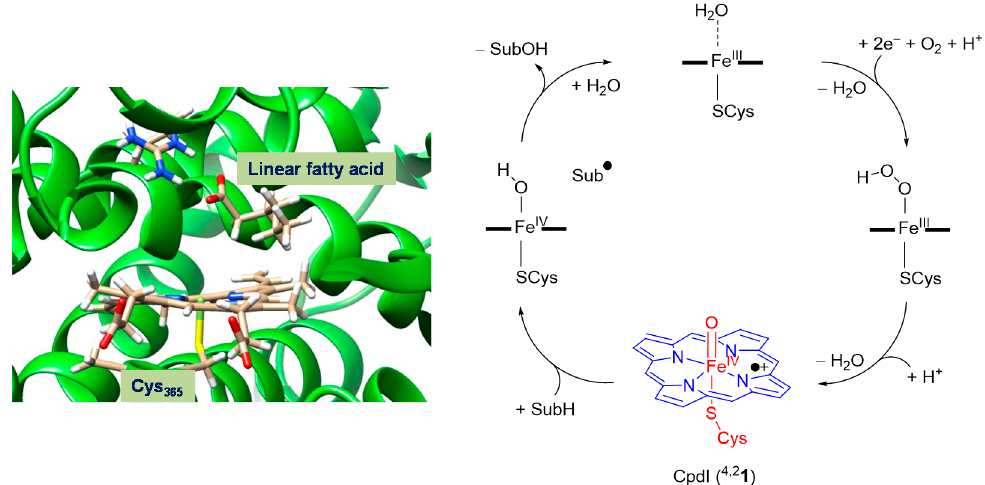
Figure 1. Active site structure of the substrate-bound, resting state of P450 as taken from the 4L40 protein databank (pdb) file and an extract of the catalytic cycle of P450 enzymes.